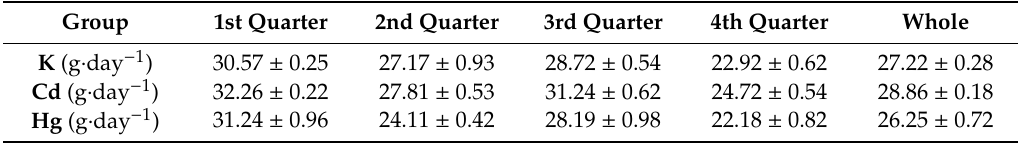
Table 6. Average food intake of male rats ±